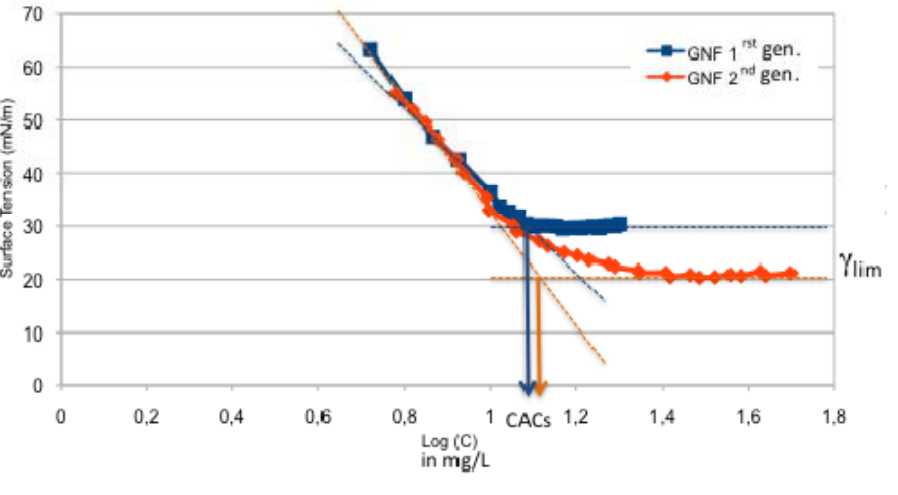
Figure 4. Air–water interfacial tension γ versus concentration for 1st and 2nd generations GNFs (blue square and orange diamond) at 25